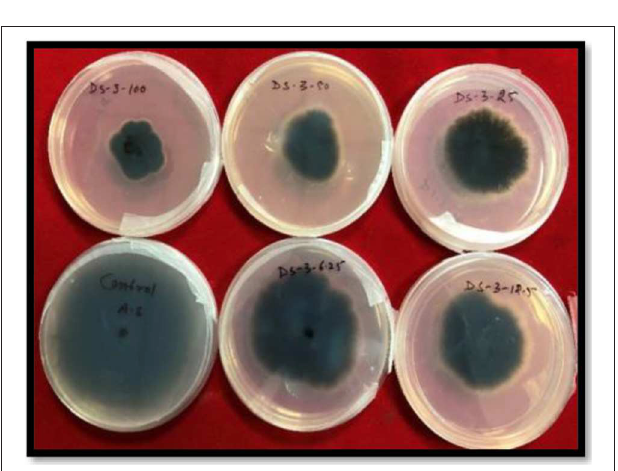
FIGURE 2 | Fungicidal activity against A. solani of (2E)-1-ferrocenyl-3-(4-fluorophenyl)-prop-2-en-1-one (3c) .